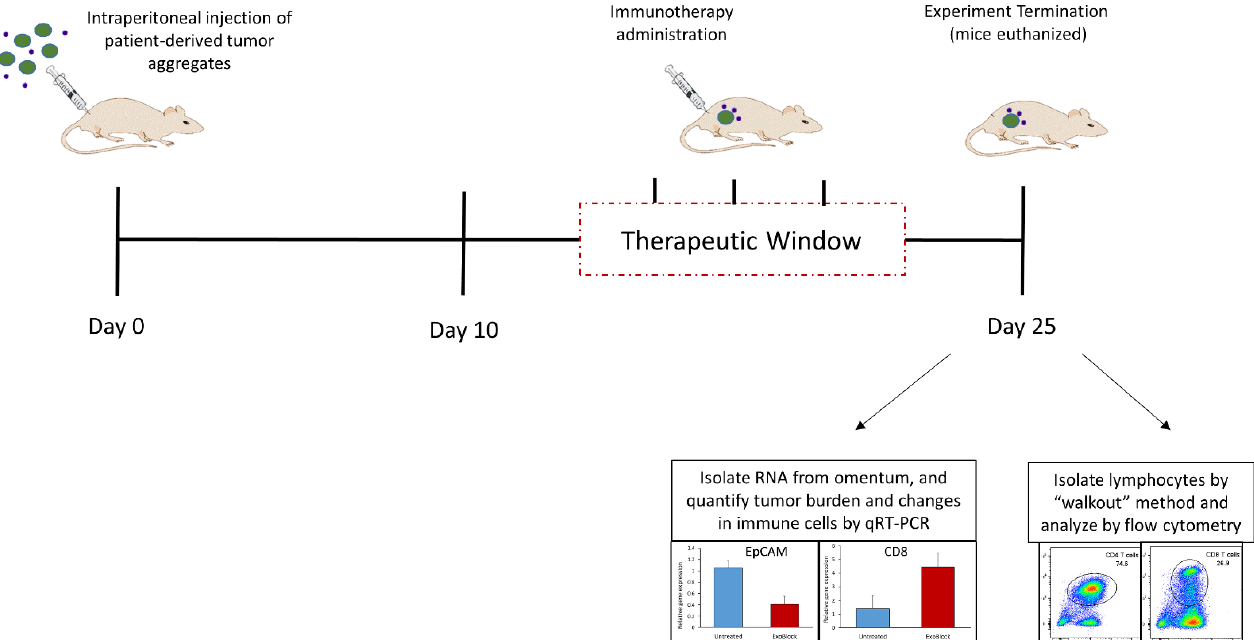
Figure 4. The Omental Tumor Xenograft (OTX) Model. Xenografts are established in the greater omentum of NSG mice by intraperitoneal injections of patient-derived tumor aggregates which include immune and stromal cells in addition to the tumor cells. Tumors are allowed to engraft and establish for 10 days. Immunotherapeutics are administered in the “therapeutic window” between day 10 and day 25. On day 25, the mice are euthanized, omenta removed and RNA isolated to allow quantification of tumor burden as well as immune cell changes by qRT-PCR. Alternatively, lymphocytes may be isolated from the omenta using the “walkout” method and phenotyped by flow cytometry. Representative data shown are original unpublished data generated by the authors.